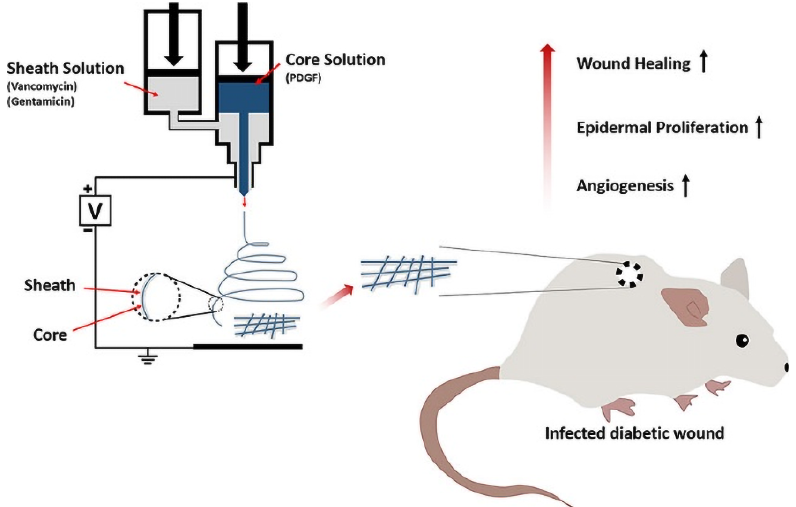
Figure 7. Preparation of PDGF/PLGA/antibiotic nanofibers and the mechanism of promoting diabetic wound healing. Reproduced with permission from [91], ACS, 2020. Dwivedi prepared, respectively, Eudragit RL/RS nanofiber membrane loaded with GS (A) and Eudragit RL/RS nanofiber membrane without GS (B) by uniaxial